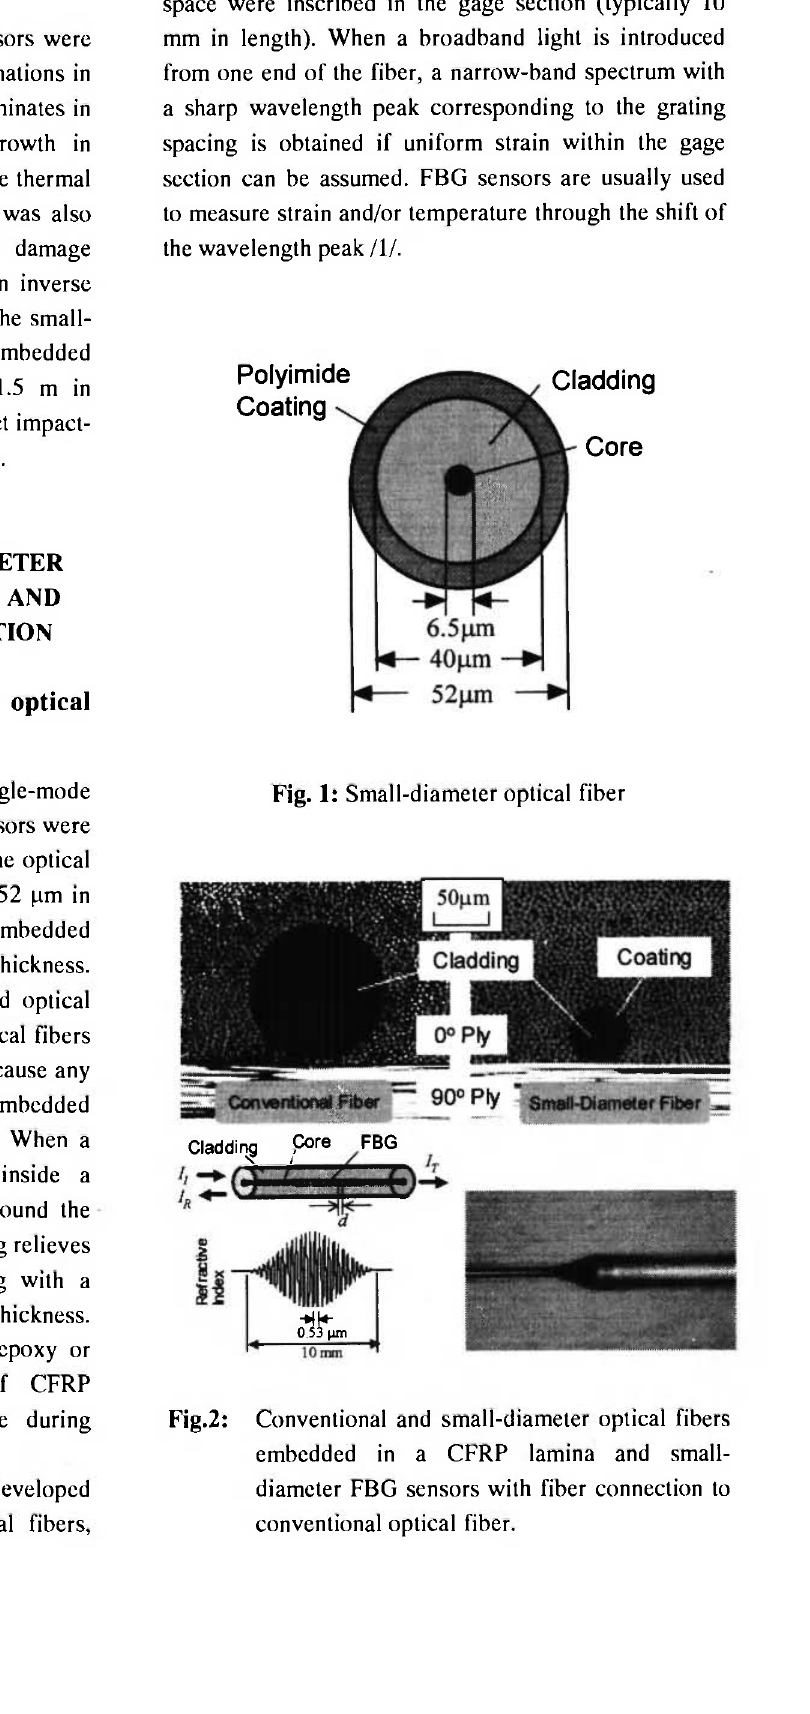
Fig. 1: Small-diameter optical fiber